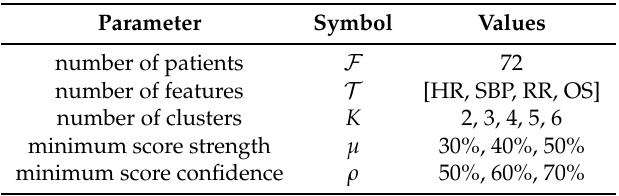
Table 2. Simulation